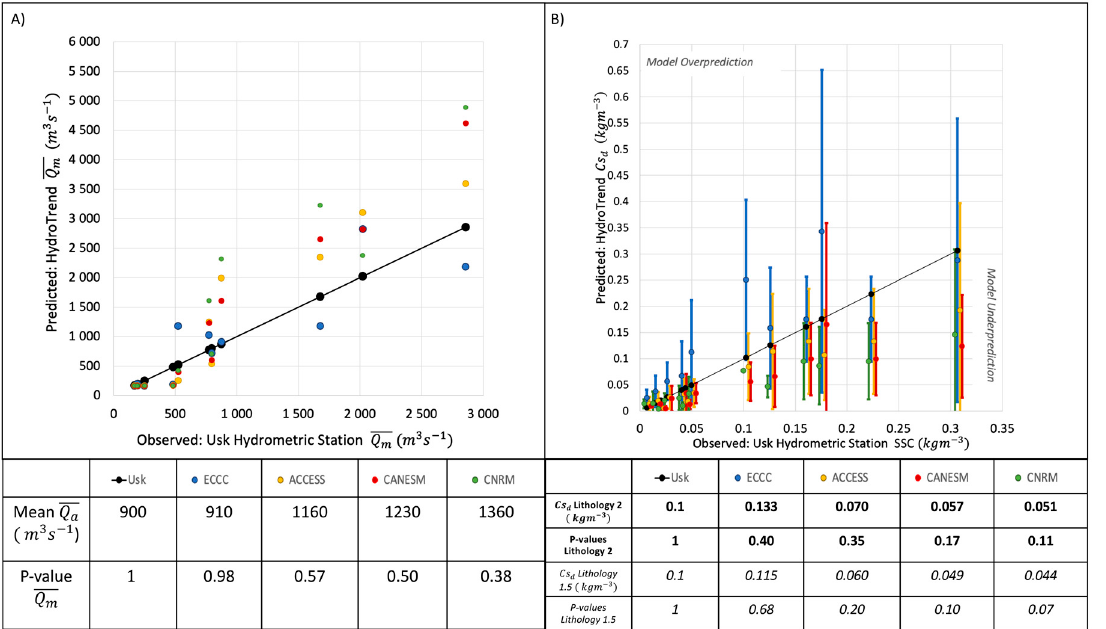
Figure 4. ( A ) Long-term monthly discharge (12 points for 12 months) averaged over the 1981–2010 epoch for Usk station compared to HydroTrend using ECCC station averages and GCM inputs. Table values are displayed to the nearest 10 m 3 s − 1 . ( B ) Measured S C at Usk (13 values over 13 days during multiple seasons and discharges), averaged per day and over multiple depths, compared to modelled daily mean S C ( Cs d ) of four GCM model runs (ECCC, ACCESS, CANESM, CNRM) using a lithology factor of 2. Values in Table 1 are displayed to the nearest 0.001 kg m − 3 using a lithology factor of 2 (bold) and 1.5 (italicized) for comparison.